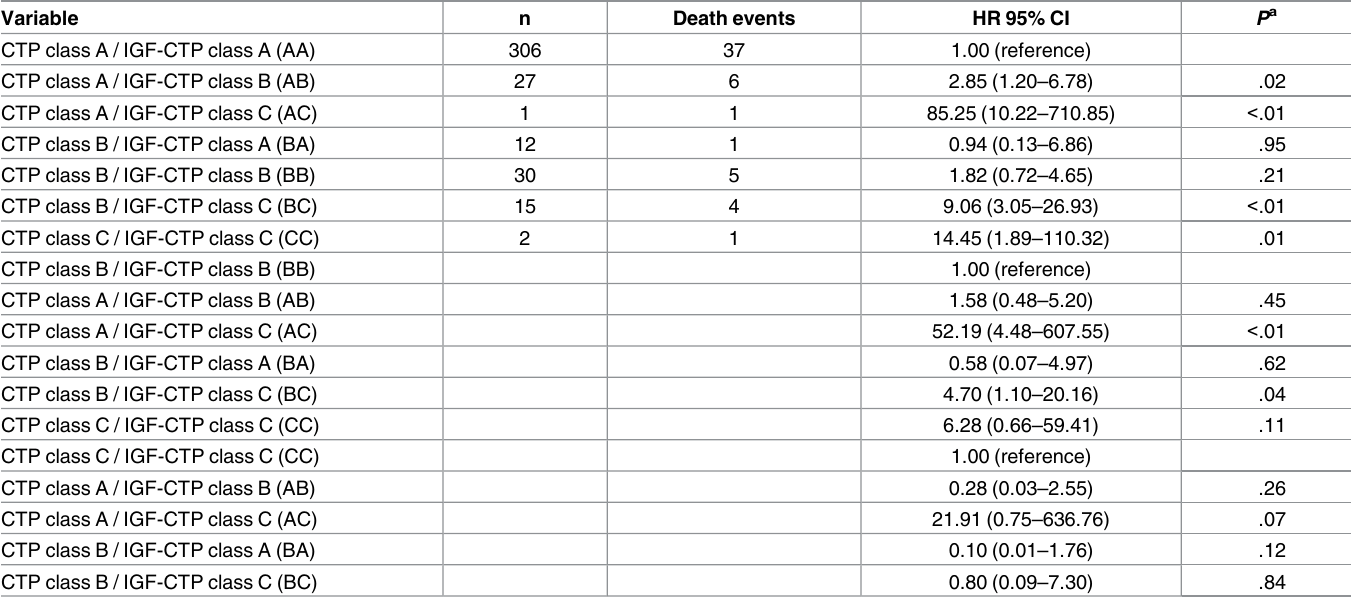
Table 4. Overall survival of the cohort by whether the CTP class was reclassified IGF-CTP class.